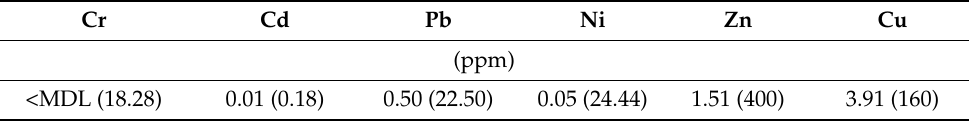
Figure 1. Heavy metal concentrations in Trichocompost. Table 3. Heavy metal contents in soils after two years of cropping with Trichoderma bio-compost; the threshold values for heavy metal contents in organic amendments in Bangladesh are given in parentheses.